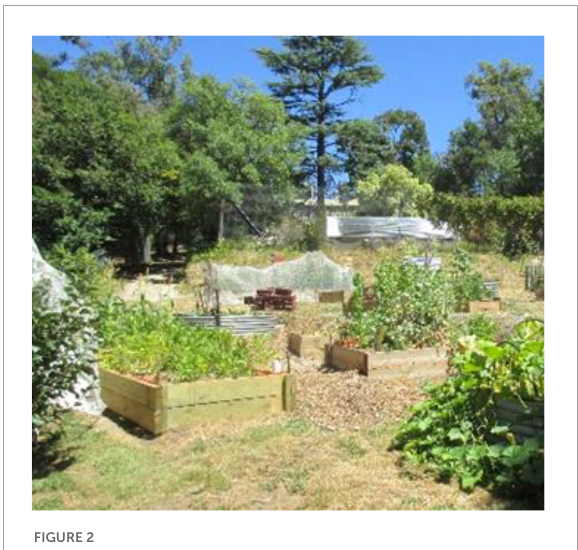
FIGURE2 Community Garden wicking